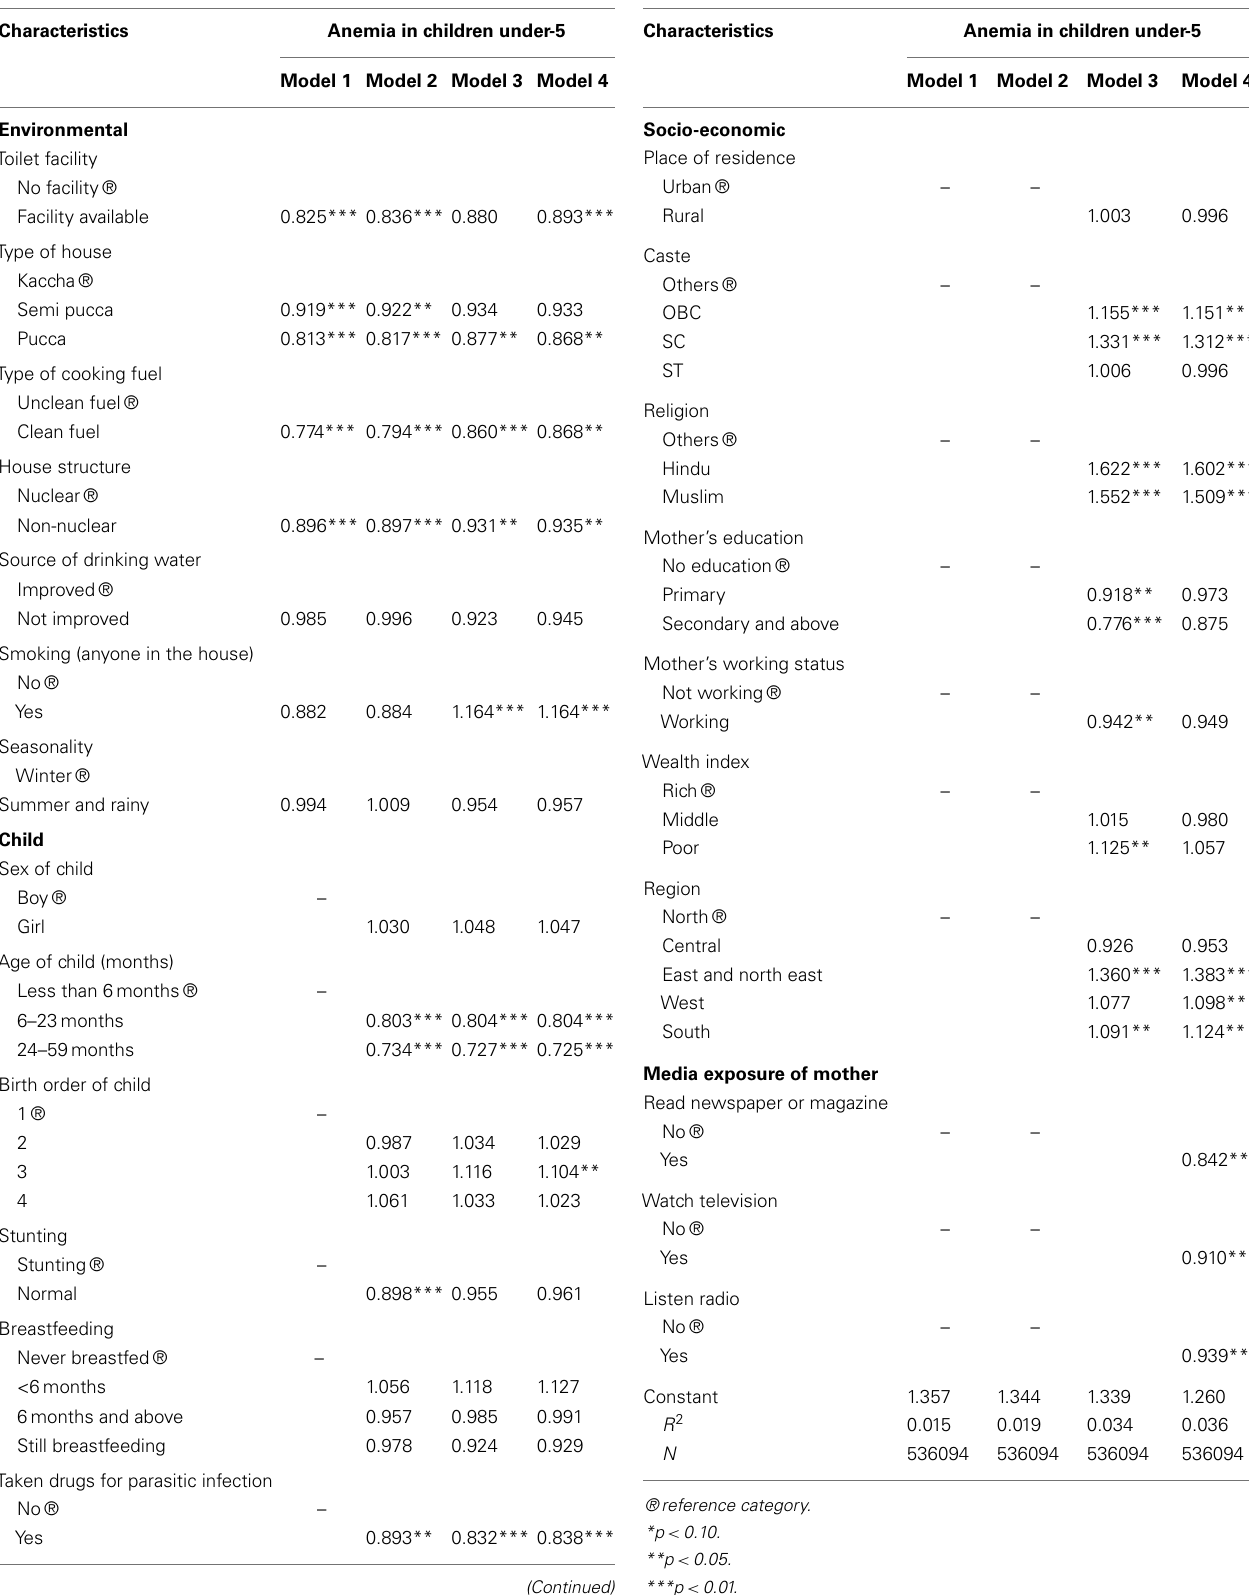
Table 2 | Regression models showing odds of having anemia among children <5years